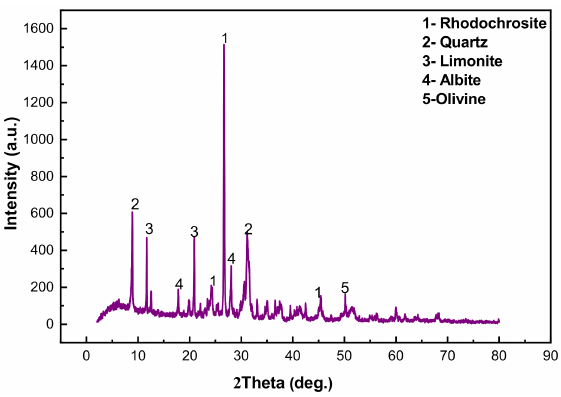
Figure 1. X-ray diffractogram (XRD) of the coarse manganese